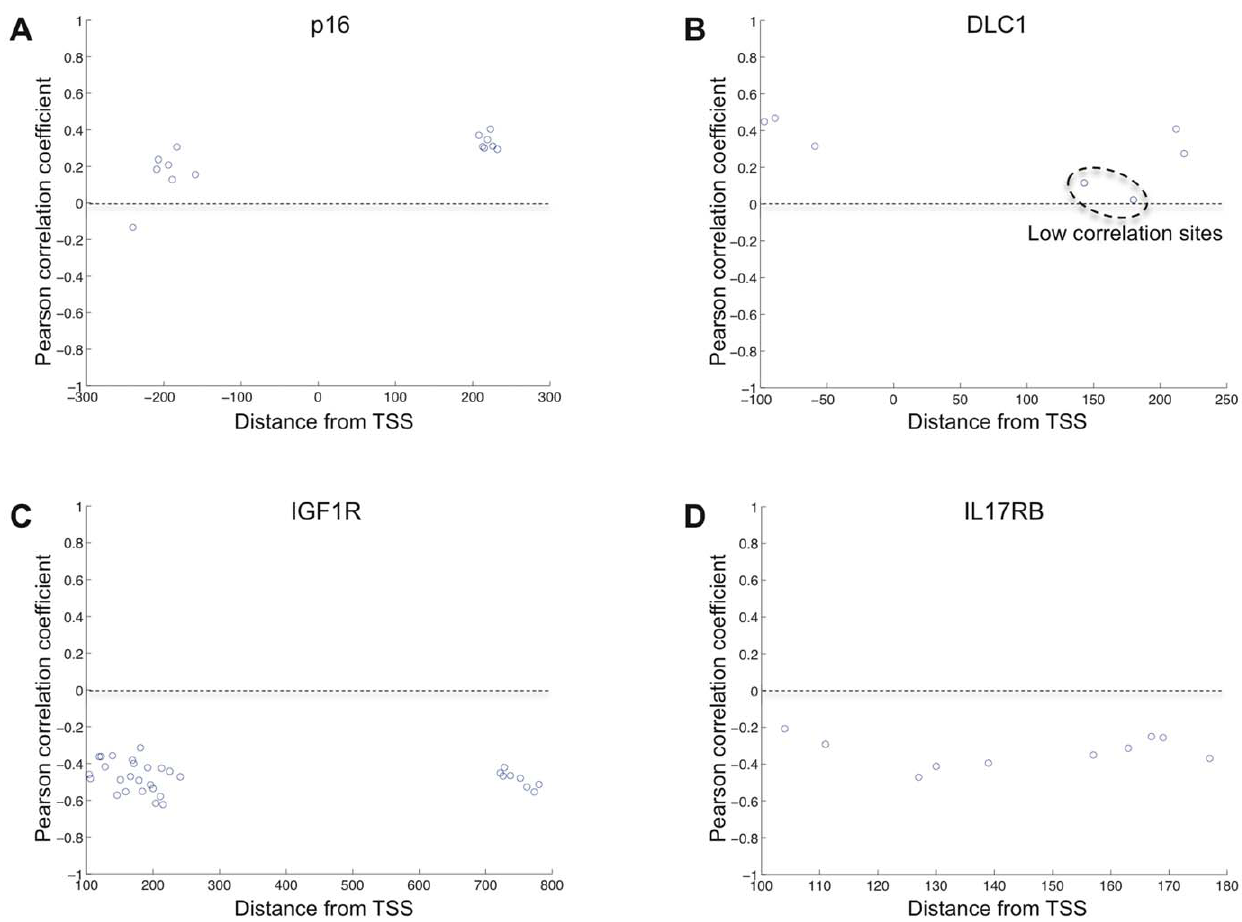
Figure 6. Pearson correlation coefficients calculated for methylation of individual CpG loci. Graphs show the Pearson correlation coefficient (y-axis) of individual CpG loci analyzed by pyrosequencing to the expression level for the corresponding gene. The distance to TSS is shown (x-axis) to demonstrate the proximity of each CpG locus to each other. Each CpG locus analyzed for p16 (A), DLC1 (B), IGF1R (C) and IL17RB (D) is depicted as a point on the graph.